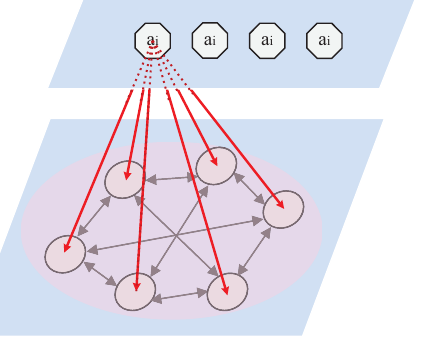
Figure 6. Adviser of vehicle